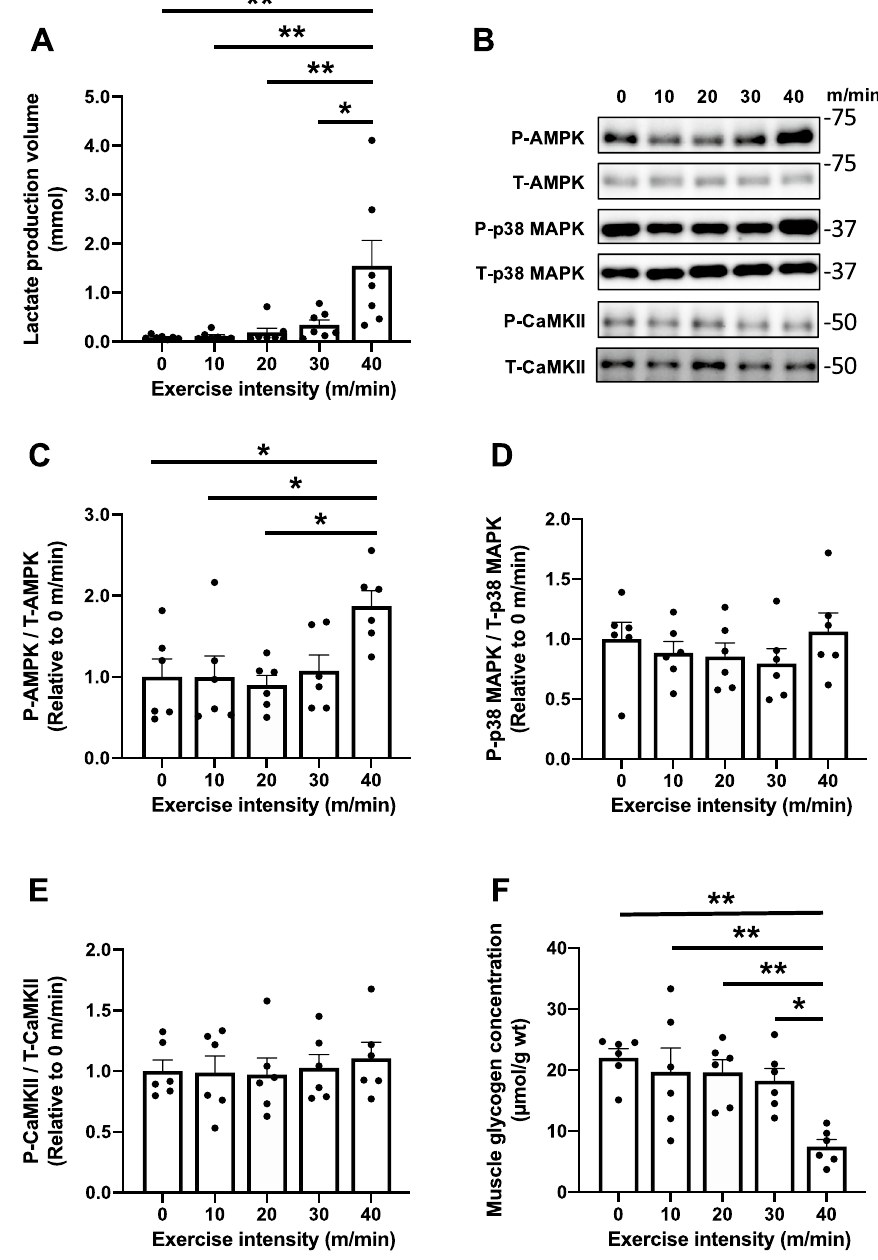
Figure 6. Acute response to various exercise intensities. Lactate production volume ( A ), representative images of signaling molecules ( B ), AMPK ( C ), p38 MAPK ( D ), and CaMKII ( E ) immediately after each exercise. Muscle glycogen concentrations ( F ) measured immediately after each exercise. Data are expressed as mean ± SEM. n = 6 in each group. *P < 0.05, **P <